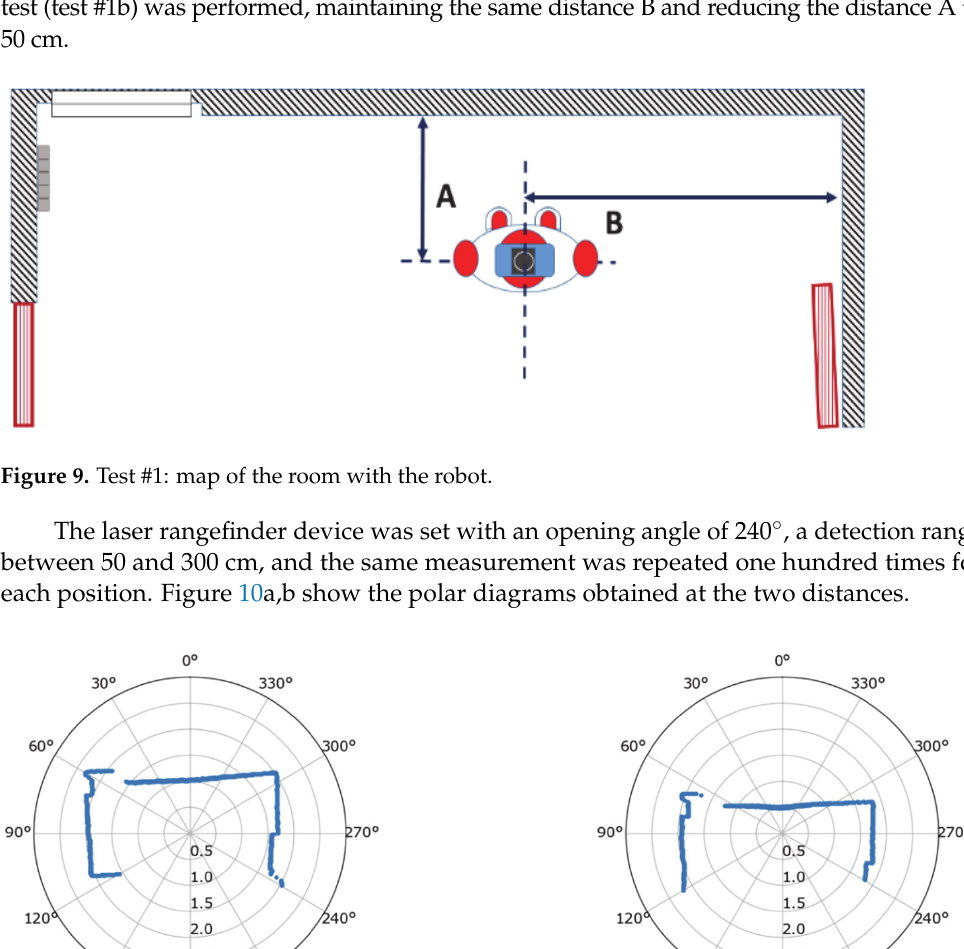
Figure 10. Polar diagrams are relative to the acquisition of the rangefinder device with the robot